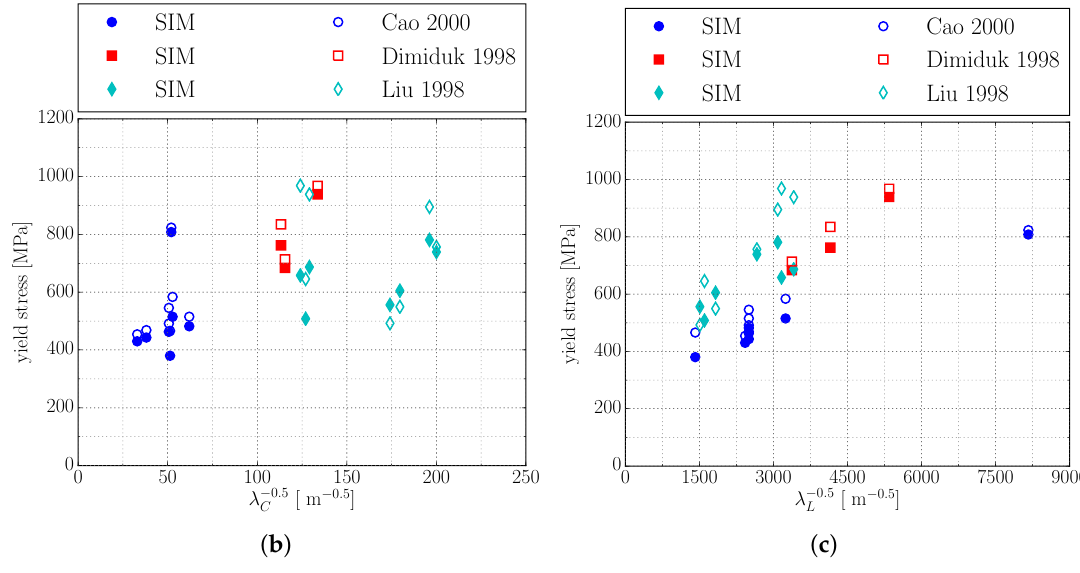
Figure 10. ( a ): Colony boundary Hall–Petch coefficient K C plotted over λ L . Full symbols: determined via the scheme illustrated in Figure 9; solid line: interpolation of calculated